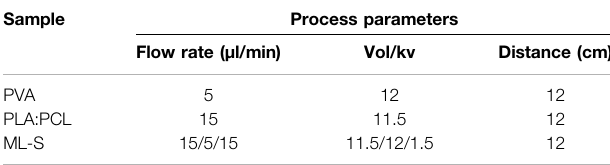
TABLE 1 | Parameters of electrospinning condition of each